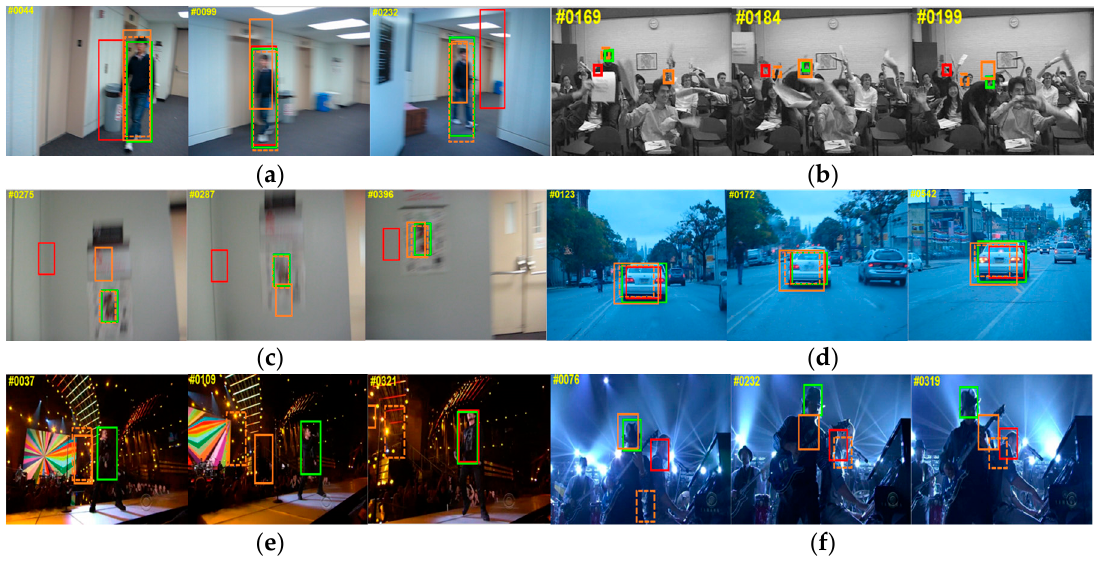
Figure 5. ( a ) BlurBody; ( b ) Freeman4; ( c ) BlurOwl; ( d ) BlurCar2; ( e ) Singer2; ( f ) Shaking. The results marked in orange, dashed orange, red and green are respectively from CXT, Struck, KCF and Ours.